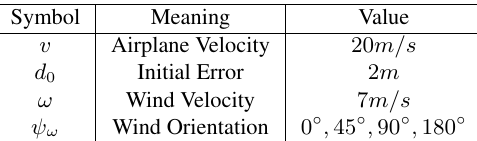
Table 2: Control parameters